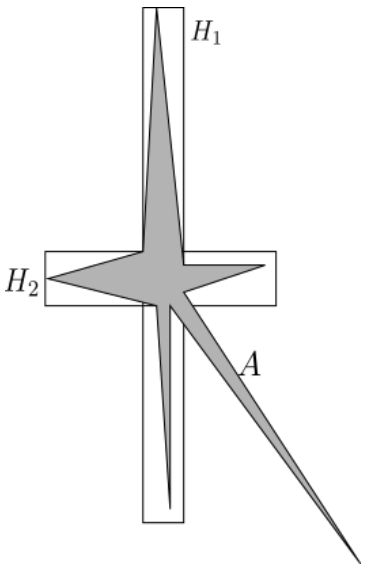
Figure 2: A schematic depiction of a situation described by Theorem 2.5 in which 2 = m (cid:48) < m , and A (cid:48) (the portion of A outside of H 1 ∪ H 2 ) is somewhat large, but transverse to all cosets of H 1 or H 2 . Note that A (cid:48) is permitted to be significantly smaller than H